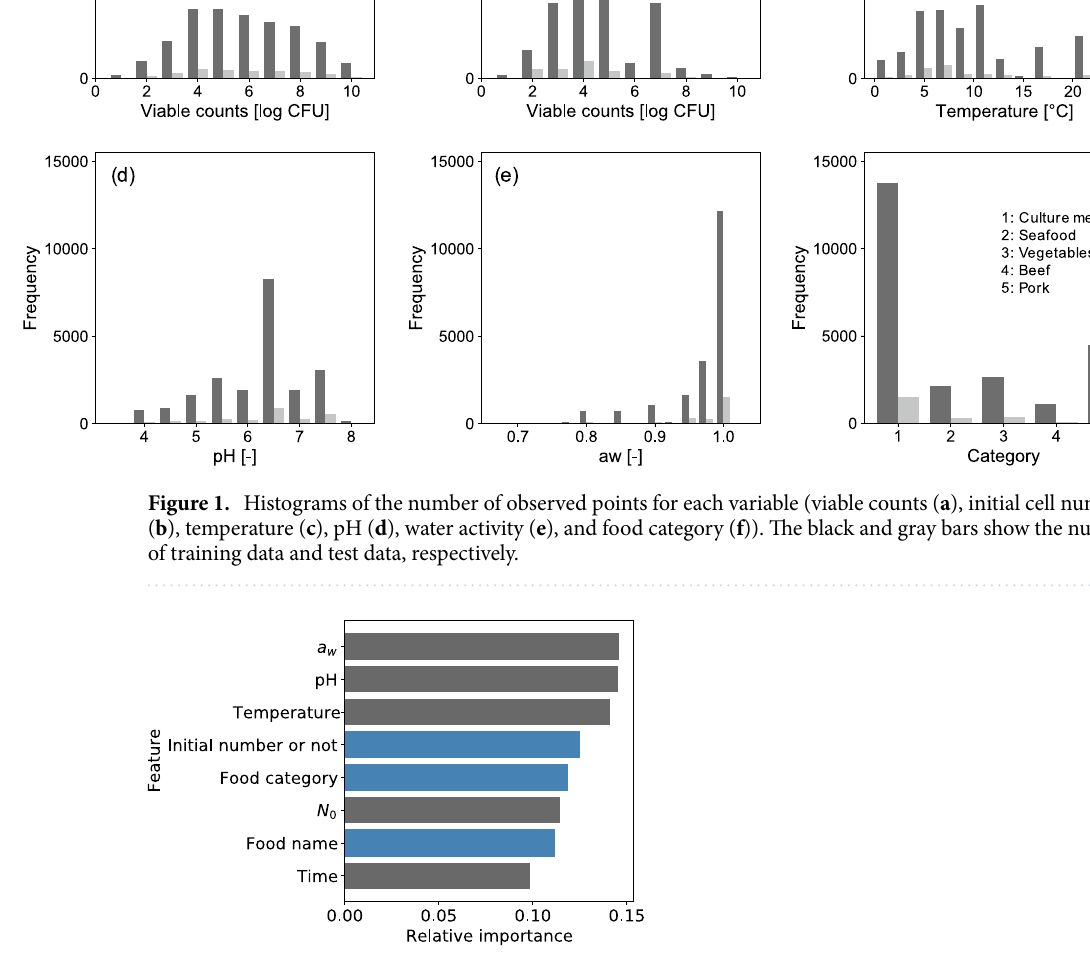
Figure 2. Feature importance of the developed XGBoost model. The X-axis indicates the relative importance, and the Y-axis indicates the explanatory variable name. Blue bars indicate categorical data, and gray ones indicate numerical